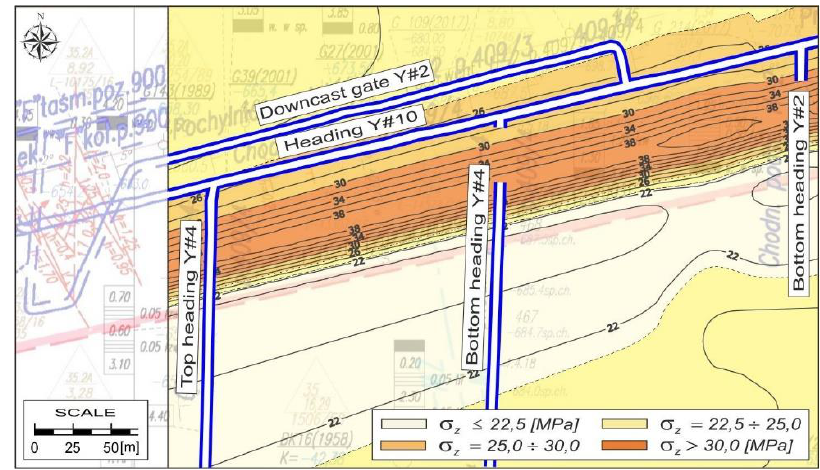
Figure 8. Vertical stress contour ( σ z ) in the coal seam (within the panel Y).